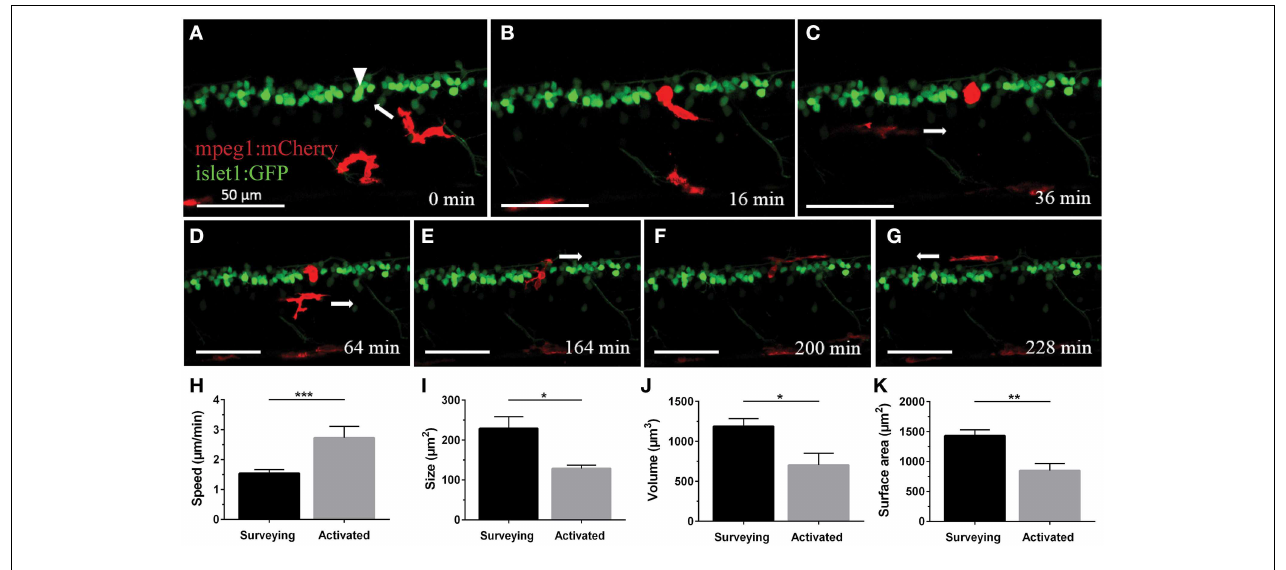
FIGURE 6 | Microglia rapidly respond and are recruited to the site of neuronal ablation. UV ablation of a GFP-expressing spinal neuron ( A ; arrowhead) resulted in only one of two surrounding microglia (red) relocating and phagocytosing the dying neuron (B,C) . Over a period of several hours, other microglia pass by the phagocytosing microglia (D) , and after approximately 2.5h the phagocytosing glial cell changes morphology back to a stellate morphology (E) , indicating termination of the phagocytosis process (F,G) . Supplementary Video 4 shows the